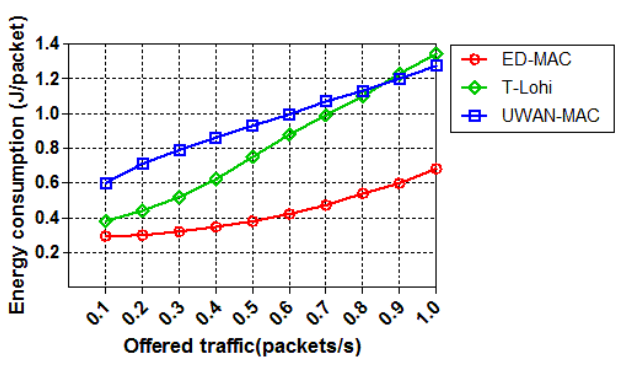
Figure 15. Energy consumption vs. offered traffic.